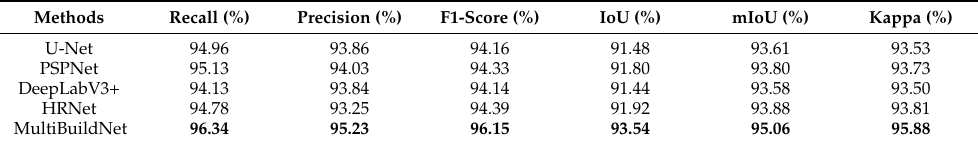
Table 8. Accuracy of building footprint segmentation on the RSIBE dataset.